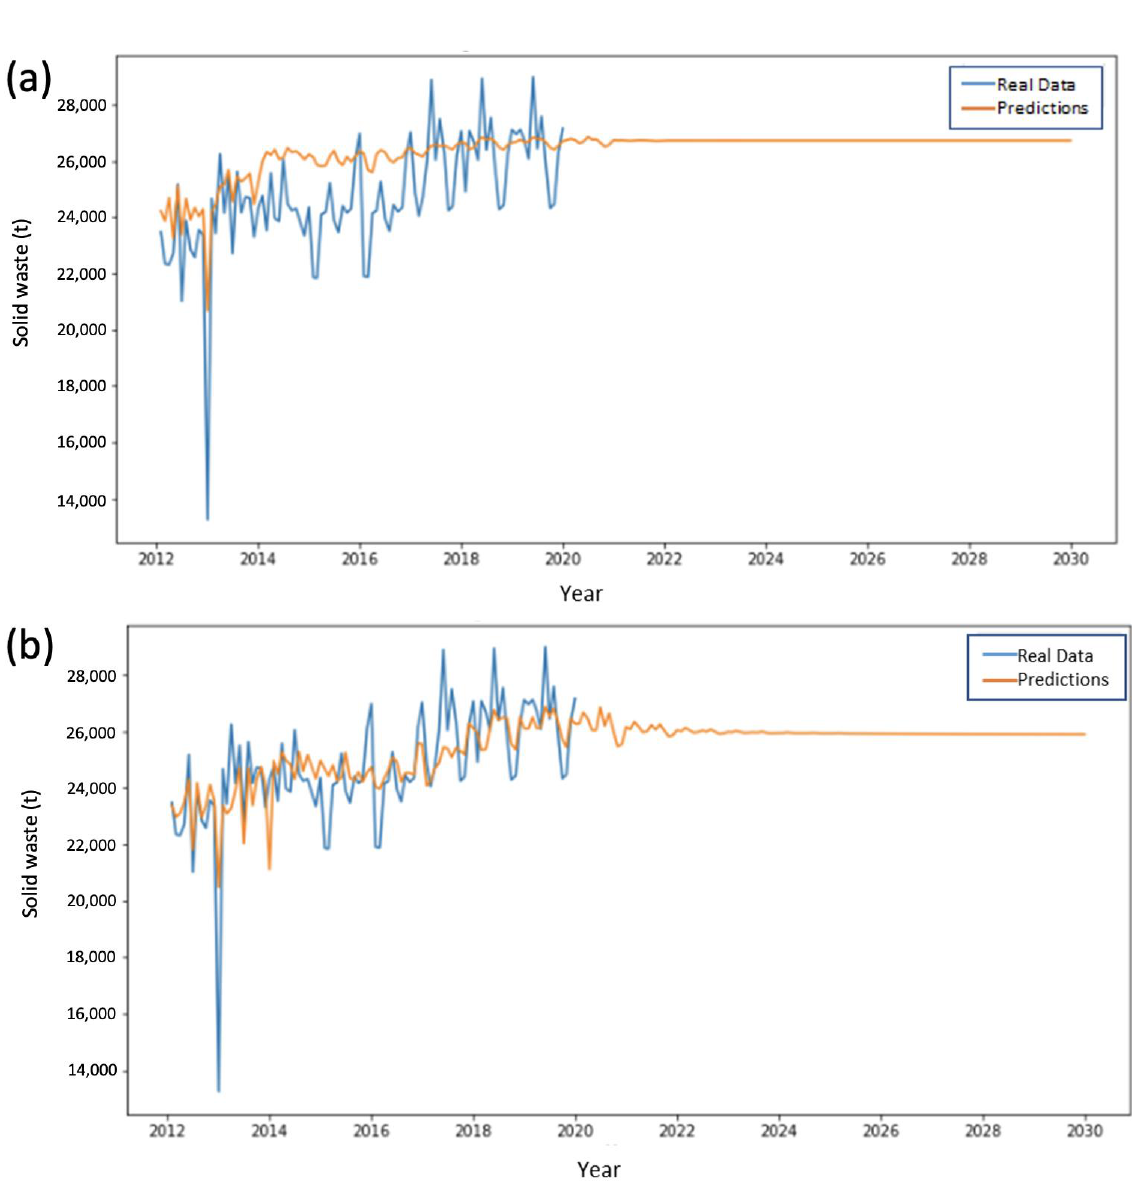
Table 3. MSE and MAE obtained by each simulation method on every ESA.